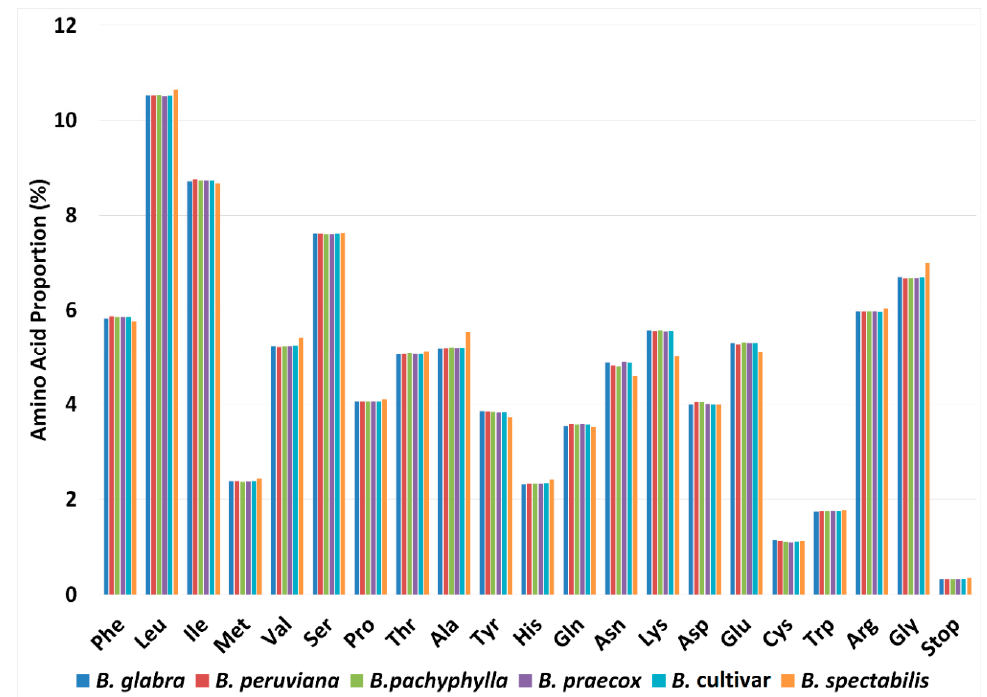
Figure 2. Percentages of amino acid in the protein-coding regions of six Bougainvillea chloroplast genomes.